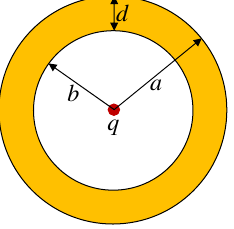
FIG. 1. Cross section of the